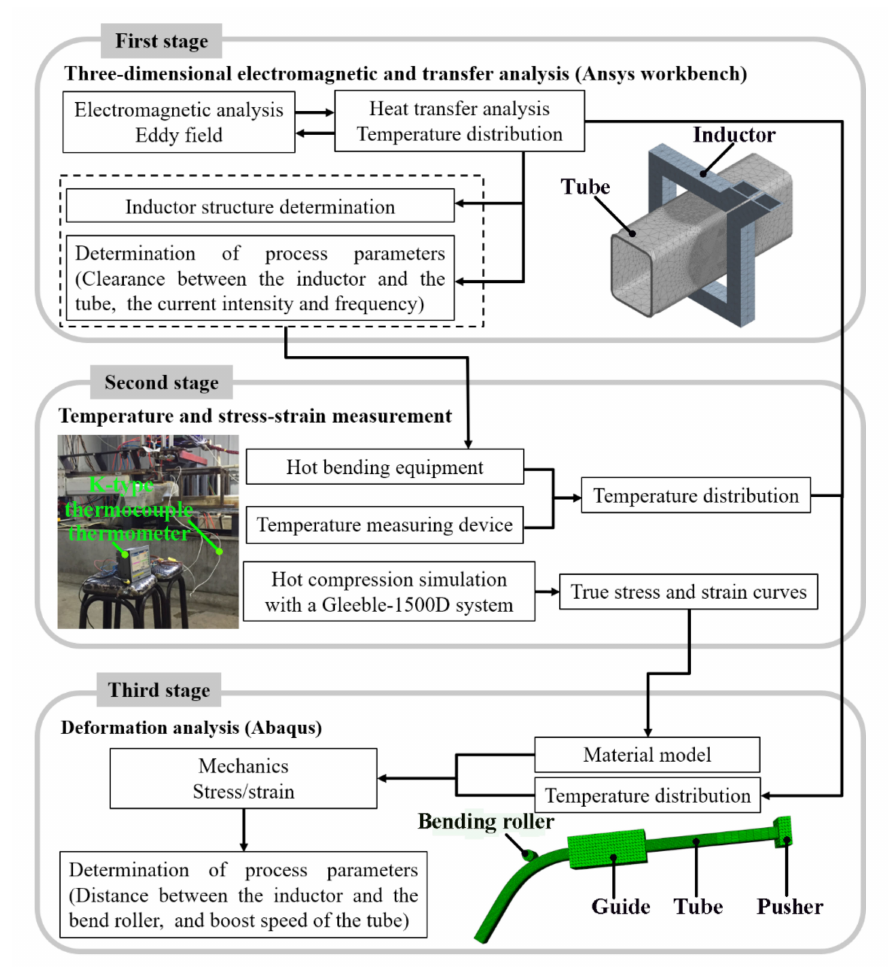
Figure 2. Procedure of local-induction-heating bending forming